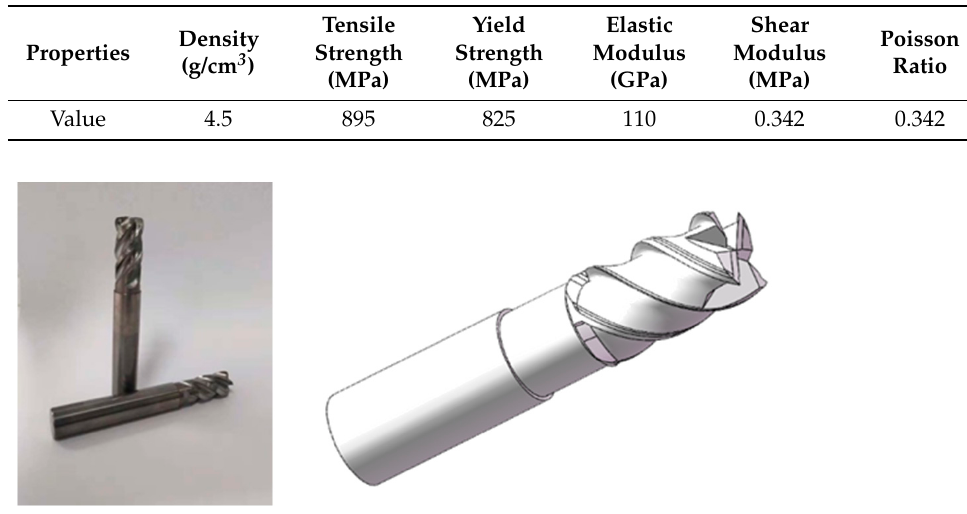
Table 2. Physical and mechanical properties of titanium alloys used in the experiment.